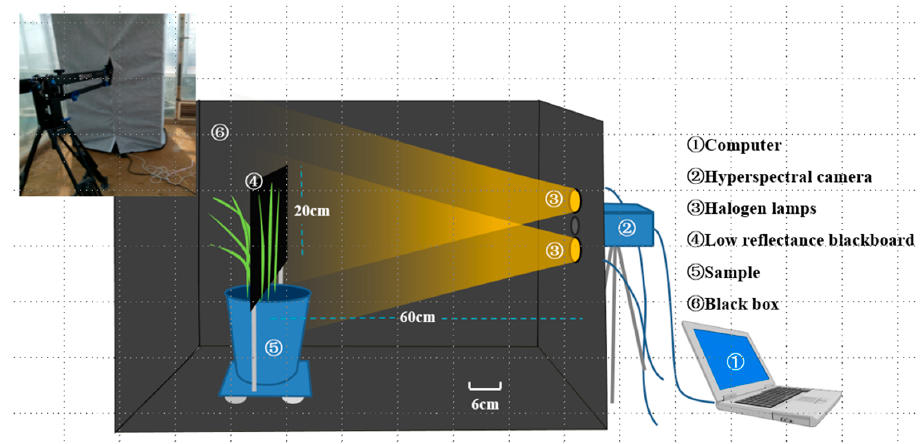
Figure 2. Test scenario of the hyperspectral imaging system.